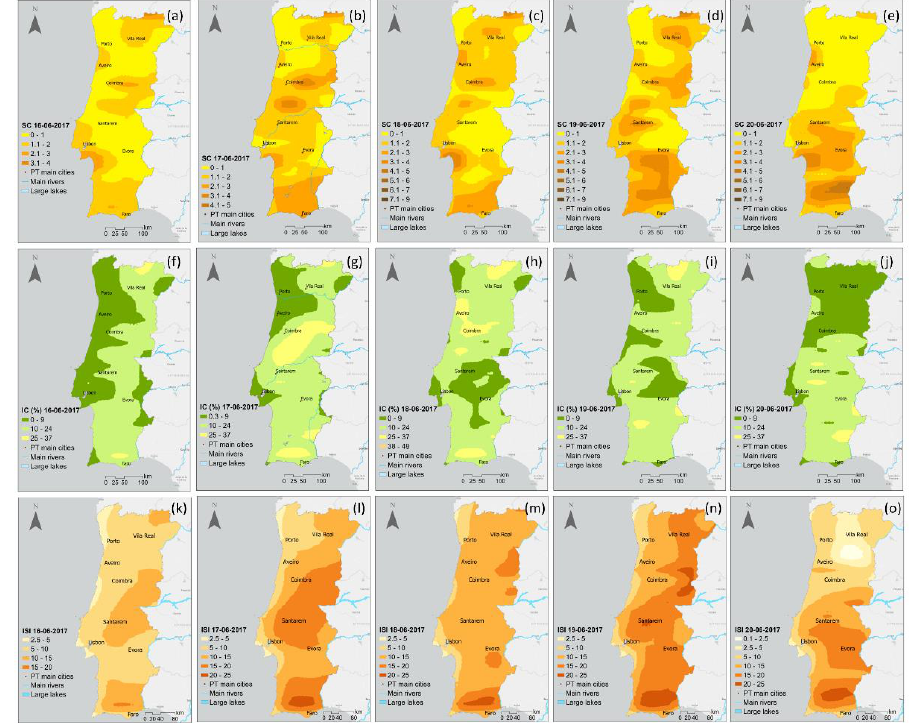
Figure A5. Daily mean values for ( a , f , k ) 16, ( b , g , l ) 17, ( c , h , m ) 18, ( d , i , n ) 19, and ( e , j , o ) 20 June 2017, for SC (upper row), IC (middle row), and ISI (lower row).